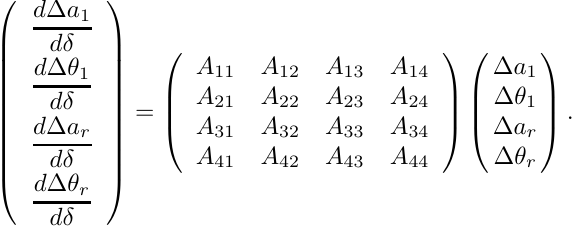
Fig. 6. Comparison of the amplitude-frequency curves of DDBG DVA by the analytical method (solid line) and the numerical one (circle